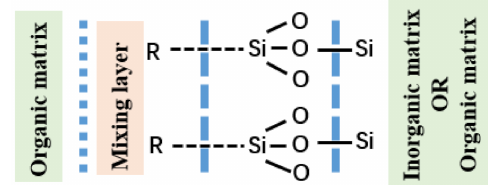
Figure 1. The coupling e ff ect of silane coupling